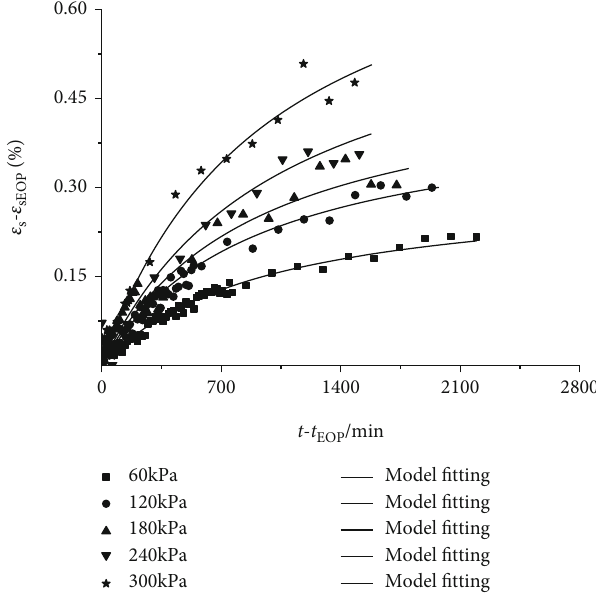
Figure 17: Fitting curves of e ff ective stress creep curve of reconstituted